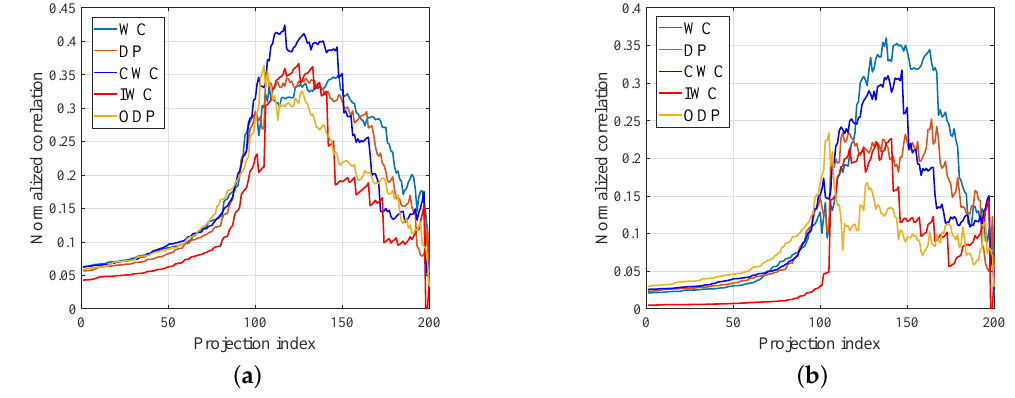
Figure 10. Comparison of the low probability of intercept (LPI) performance. ( a ) SIR = − 25 dB, signal-to-noise ratio (SNR) = − 5 dB ( b ) SIR = − 35 dB, SNR = − 5